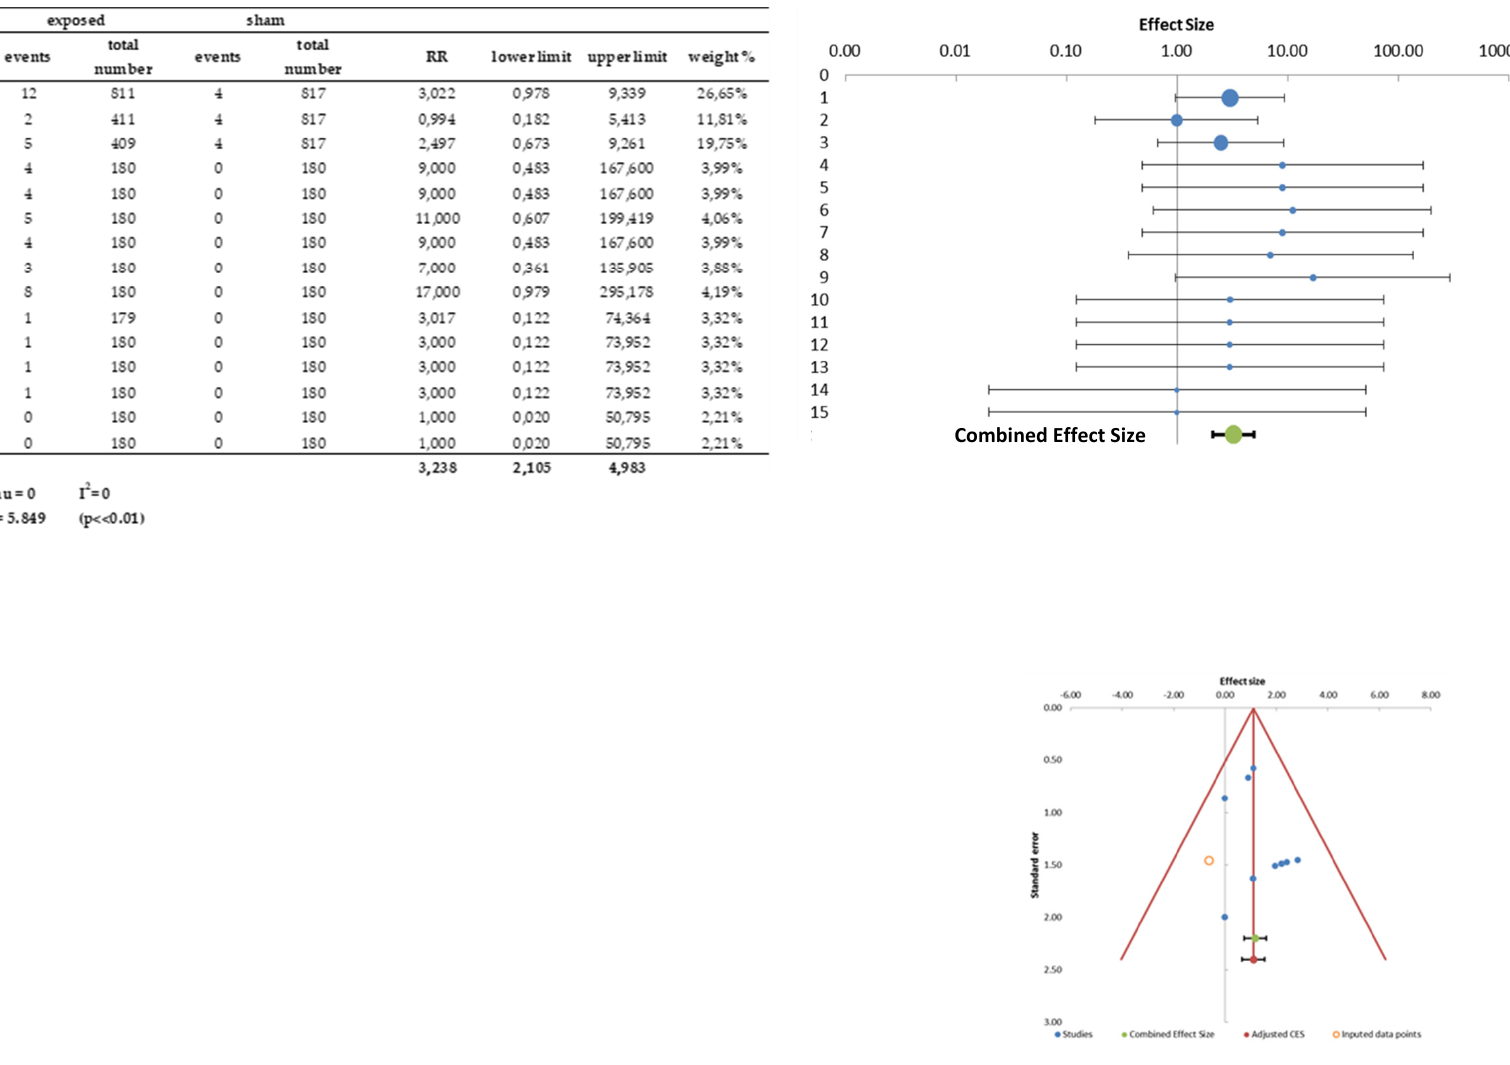
Figure 4. Raw data, forest plot and funnel plot of the heart malignant tumors (NTP 2018^ identifies the NTP mice study).